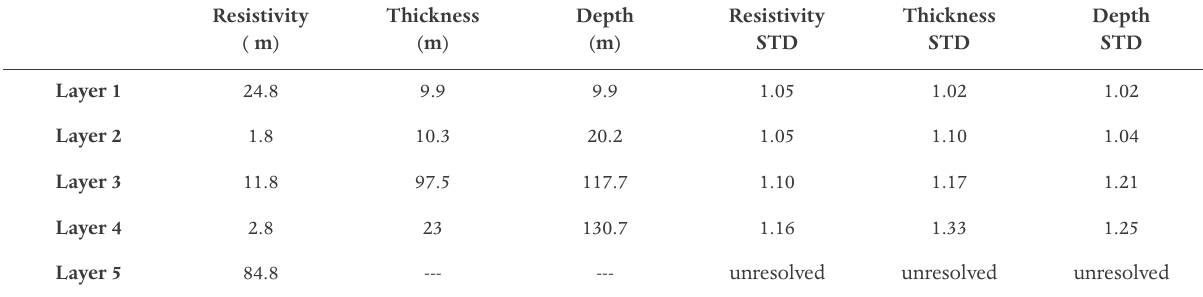
Table 1. Model parameter analysis for the 5 layer 50 × 50 m loop reference model at the San Rossore reference site. The model parameter uncertainties are stated as STD-factors [Auken et al. 2005]. STD below 1.2 indicates well resolved parameters while STD above 2 corre- sponds to unresolved parameters.